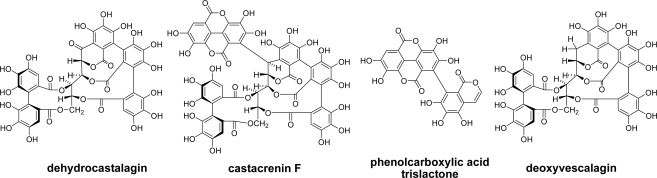
Pyrolysis products of castalagin and vescalagin [70,72].